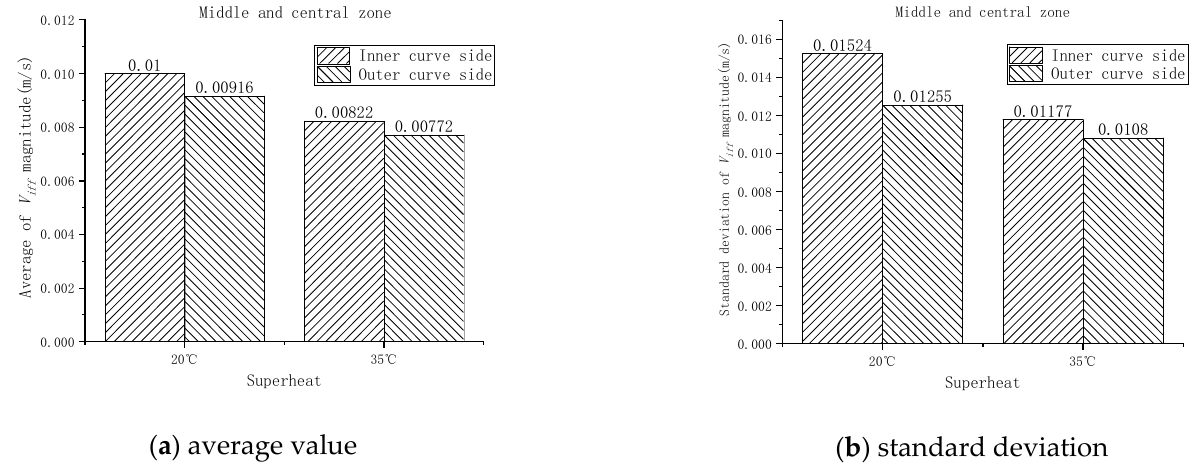
V magnitude of middle and iff